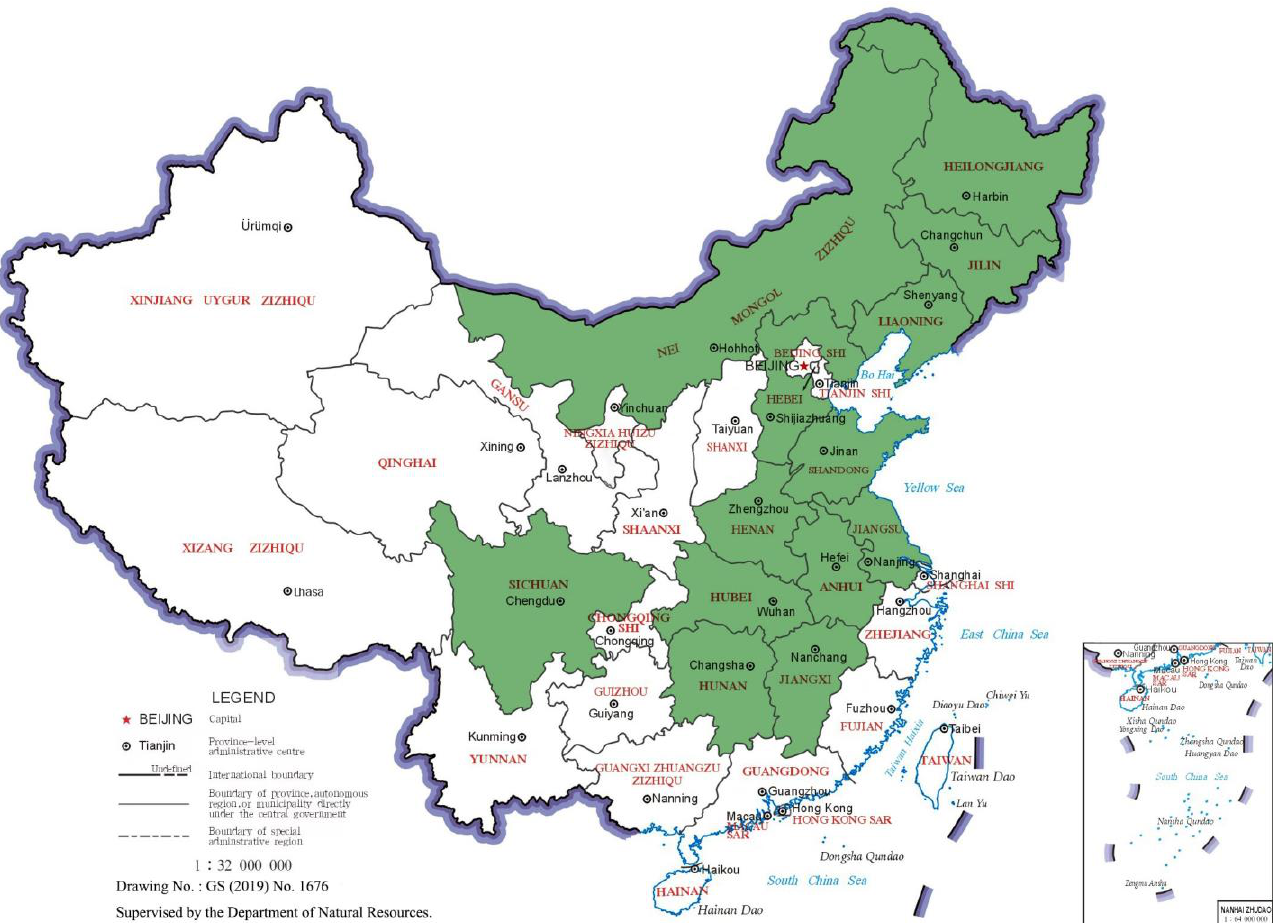
Figure 1. Distribution diagram of major grain-producing areas in China. The green part of the map shows the distribution of major grain-producing provinces in China.